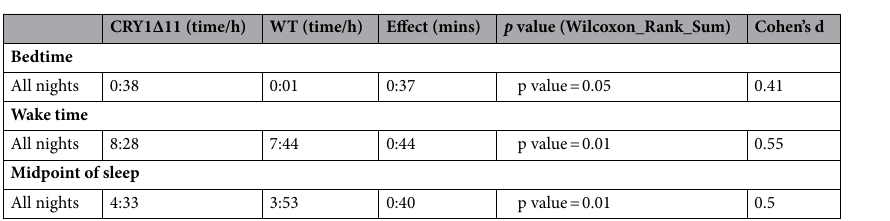
Table 1. Summary of Mean Post-Sleep Diary Data. The table displays the bedtime, wake time and midpoint of sleep for variant carriers and controls. Bed time refers to the time when the participant went to bed with intention of going to sleep. Wake time refers to the time the participant woke up. Midpoint refers to the midpoint of sleep.